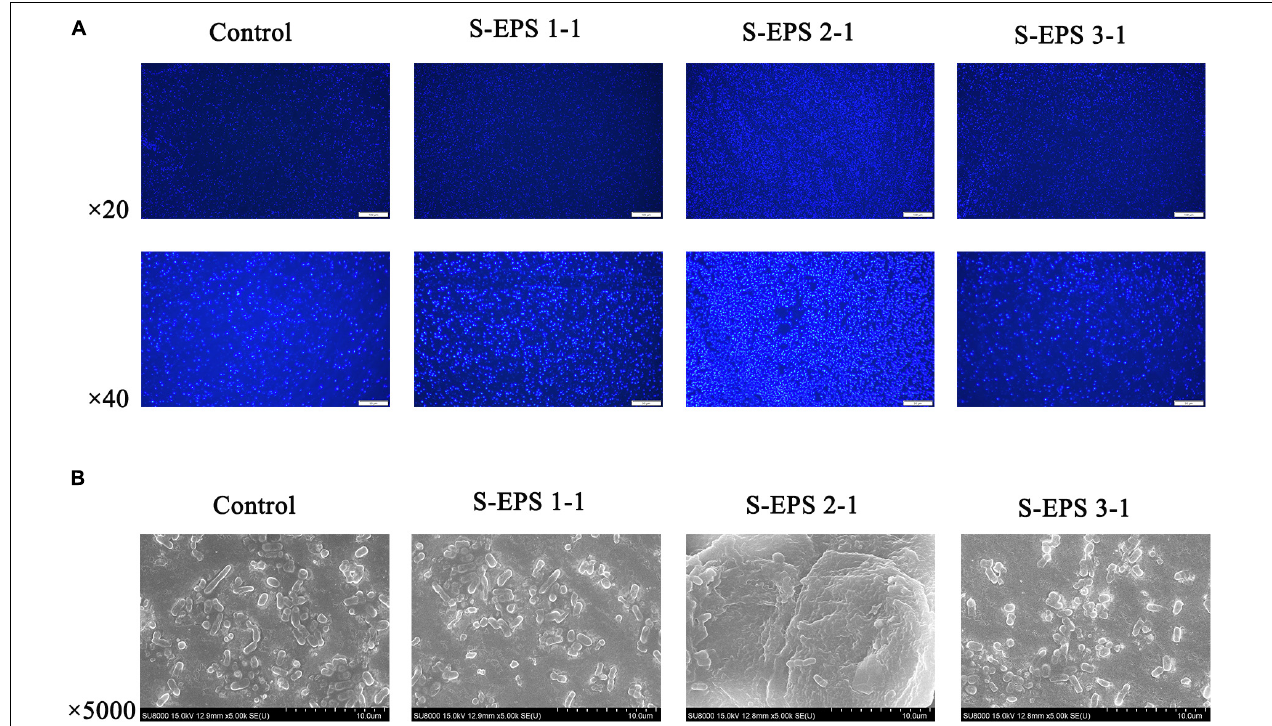
FIGURE 7 | (A) Fluorescence microscopy image and (B) SEM images of S. flexneri biofilm formation treated with 4 mg/ml of different S-EPS fractions compared to control. Scale bars indicate 100 µ m (20 × ) and 50 µ m (40 × ) in (A) , and 10 µ m in (B)